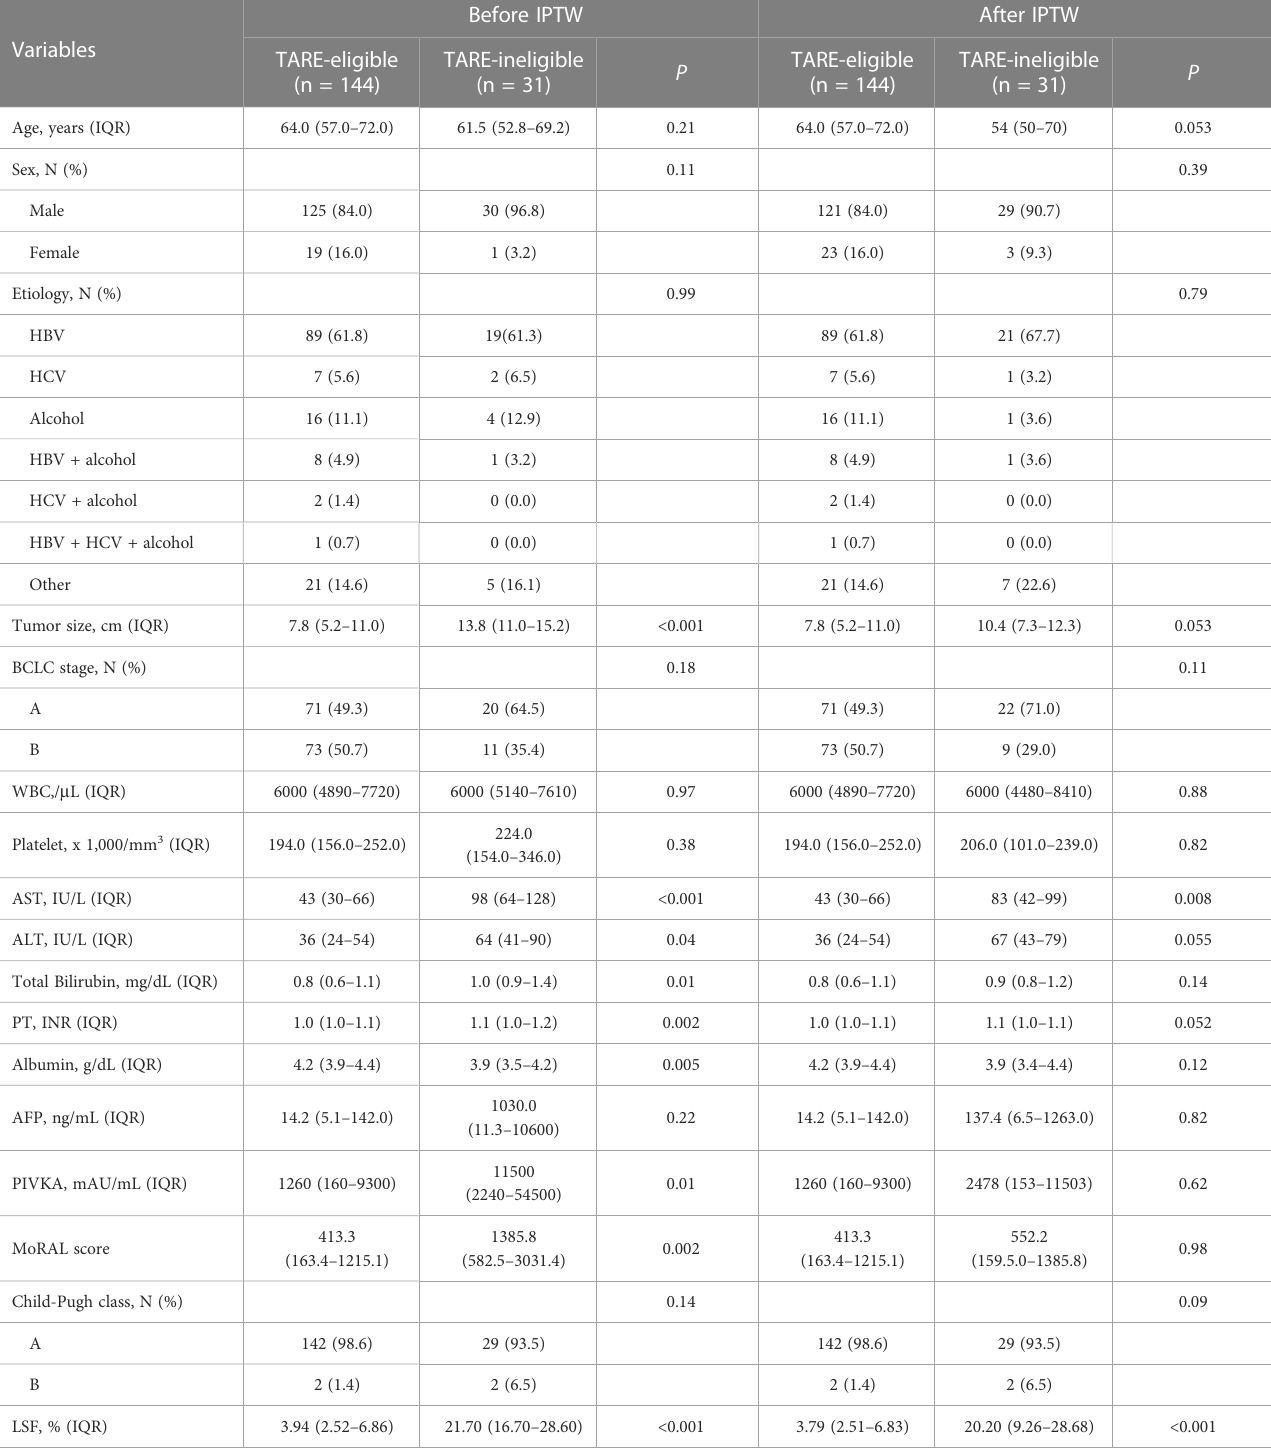
TABLE 1 Baseline characteristics of the study population before and after